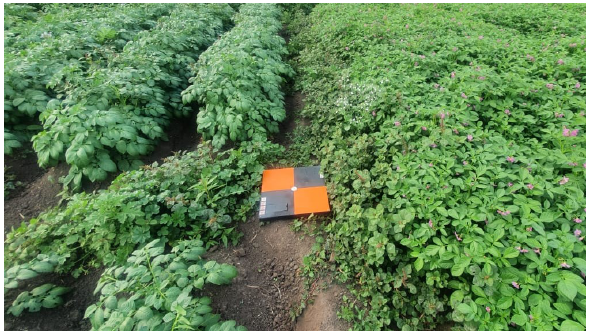
Figure 3. GCP marker -